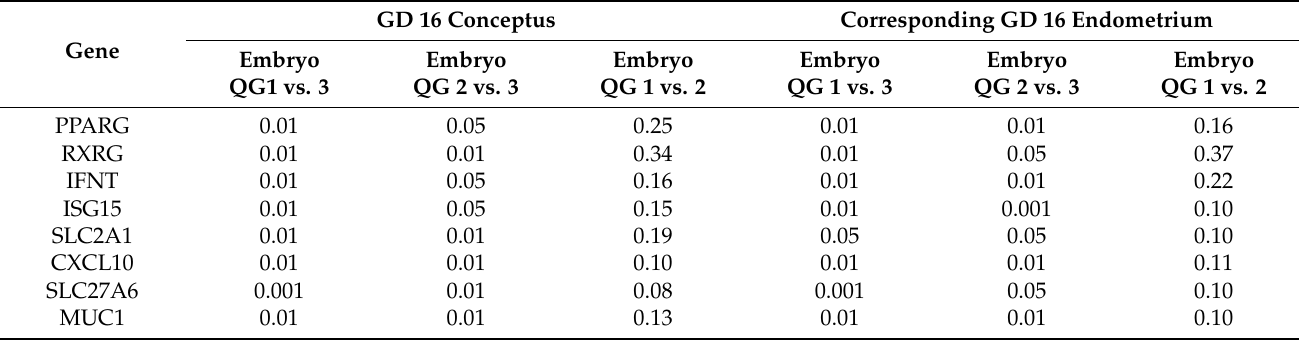
Table 3. p -values of pairwise comparisons of protein expressions in gestational day (GD) 16 conceptus 1 and